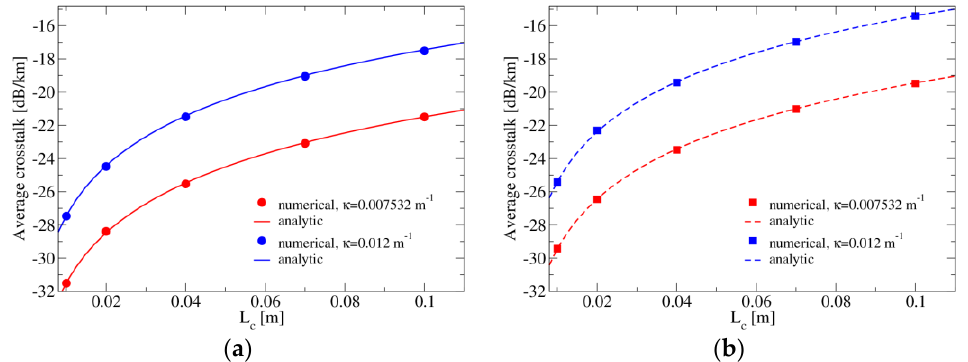
Figure 9. Average crosstalk dependence on the correlation length scale L c , computed numerically and based on analytic expression from [8] for the case of ( a ) Gaussian and ( b ) exponential distribution of uniform segment lengths.